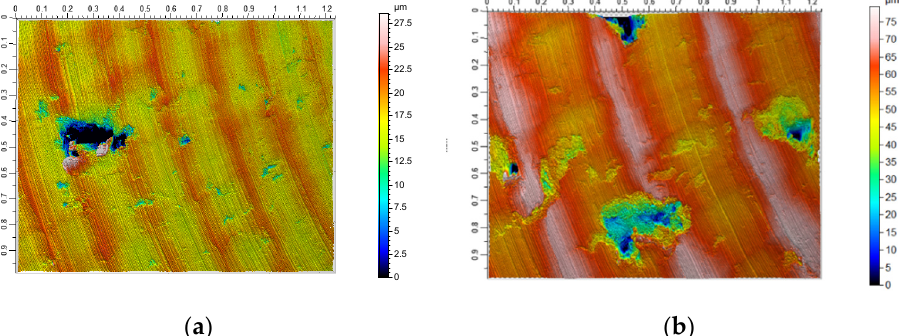
Figure 8. View of the surface of the samples obtained in the SLM process after face turning at higher values of feed: ( a ) F3 = 0.20 mm/rev; V3 = 0.5 vc max; ( b ) F5 = 0.40 mm/rev; V2 = 0.75 vc max.